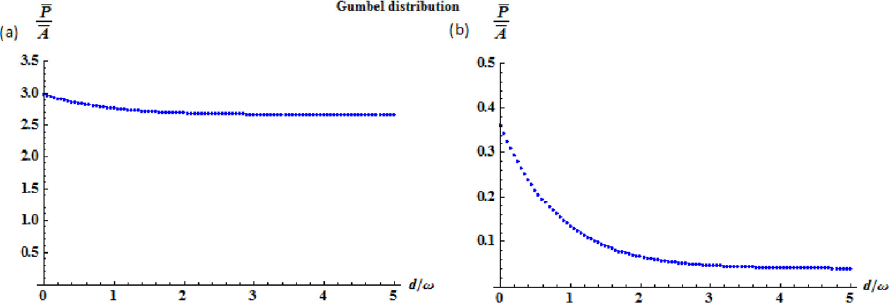
Fig. 9 Surface roughness decreases the adhesion effects in contact. (a) The pressure of contact for λ = 5 in a fixed roughness. (b) The roughness of the surface decreased by 10 with λ = 5 and resulted in considerable reduction in the pressure.